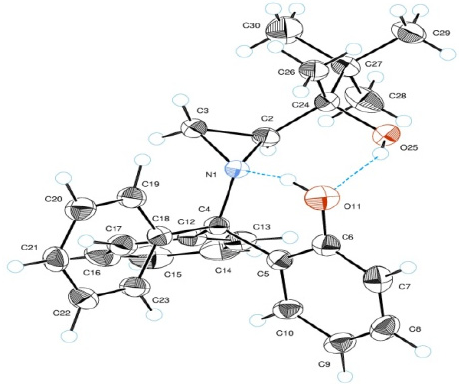
Figure 2. Crystal X-ray structure of carbinol 6d1 .